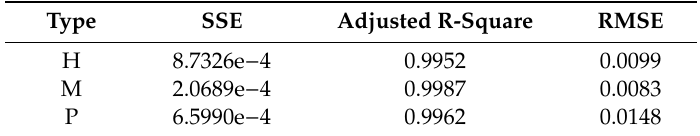
Figure 4. The LM Gaussian distribution fitting results of three types for PCCS. Table 2. The goodness of fit for the Gaussian distribution of the three types of PCCS.